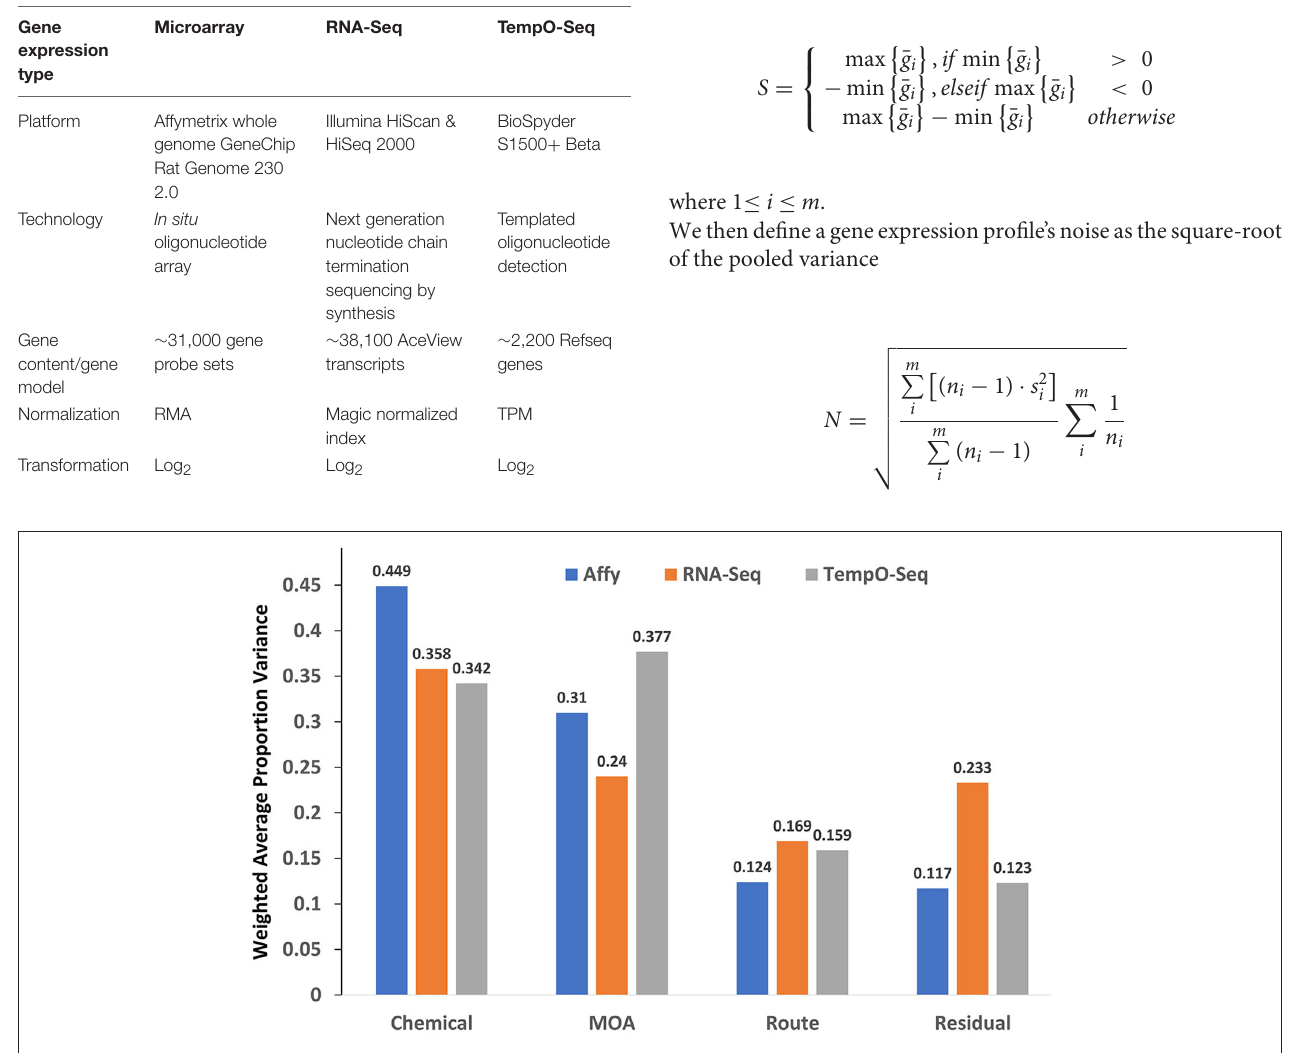
FIGURE 2 | Variance components explained. Shown on the y-axis is the weighted average of the proportion of variance explained by platform for each of the mixed effect linear model terms denoted in the x-axis.